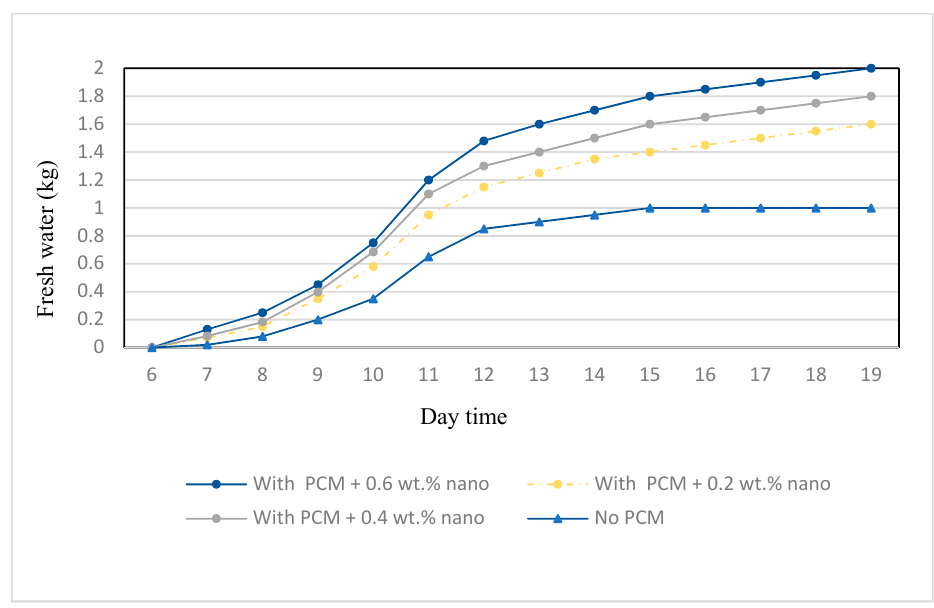
figure shows that adding more GO to paraffin causes more fresh water production which indicates